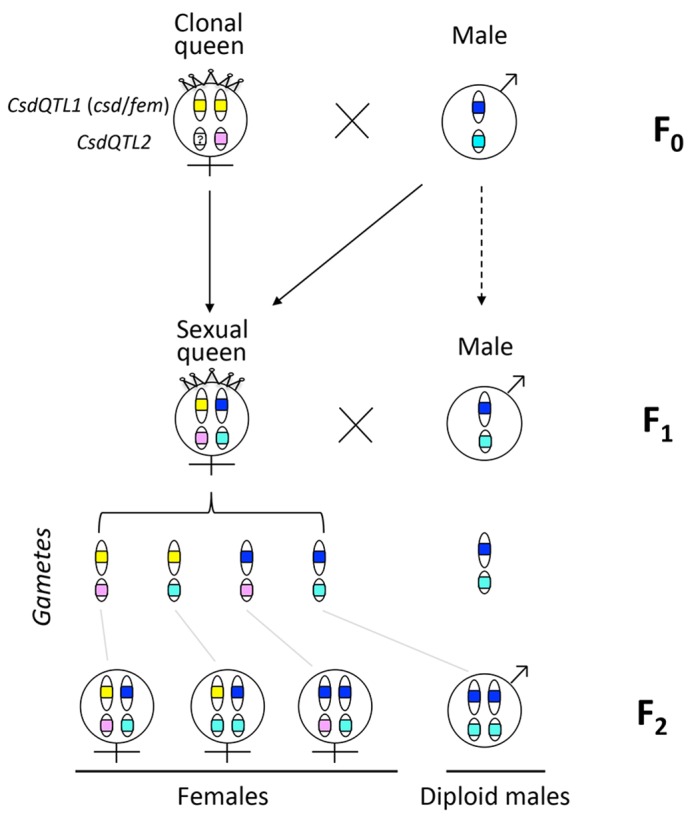
Graphical summary of the results, with different CSD alleles color-coded.QTL mapping (Fig 2) and F2 diploid male ratios (Table 1) both support a two-locus model of sex determiation in the workers. CsdQTL1, which has homologs of csd and fem, has diverged between male and female clones (Fig 3), assuring heterozygosity at that locus in F1 females. Both tra homologs are homozygous in clonal queens (F0), suggesting that if queens use the same sex determination mechanism as do workers, CsdQTL2 should be heterozygous. However, none of the exonic regions at CsdQTL2 are heterozygous in all of the queen samples. If this result is not a technical artifact, it suggests either thtat queens use a separate sex detemination mechanism, or that the sex determination mechanism in V. emeryi does not depend on heterozygosity in protein sequence at CsdQTL2. In any case, the molecular mechanism at CsdQTL2 remains a mystery.